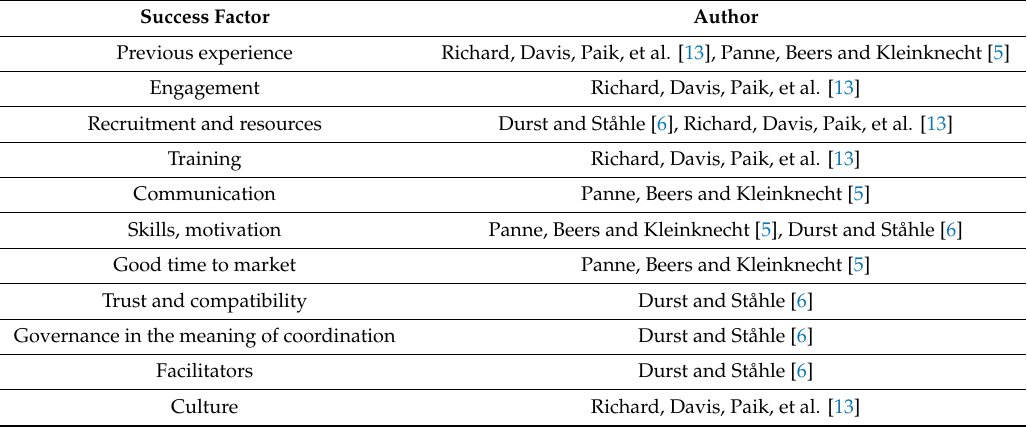
Table 1. Success factors for open